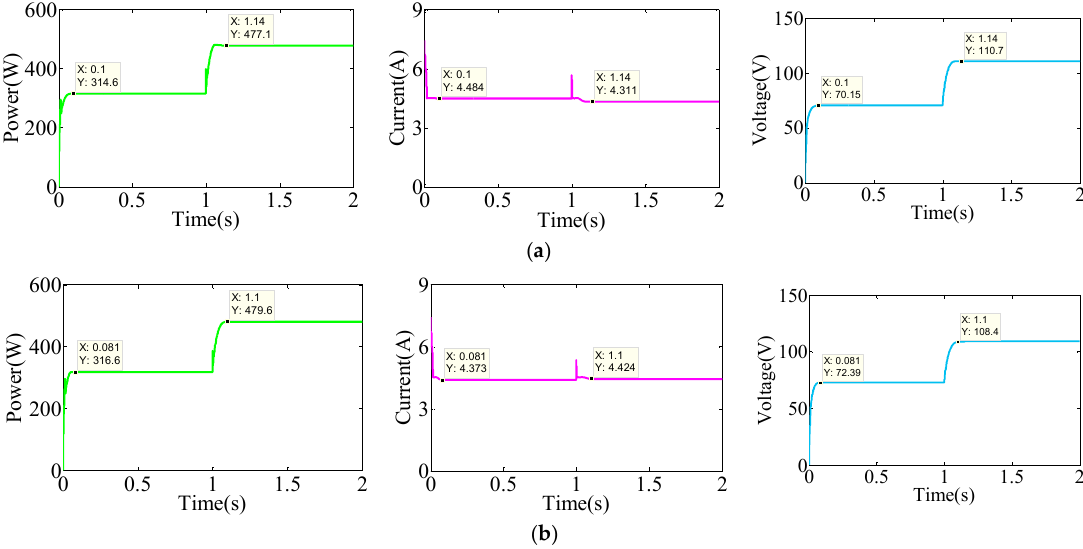
Figure 11. Power, current and voltage tracking curves of FPA and MFPA from strong shading to weak shading ( a ) FPA; ( b ) MFPA.